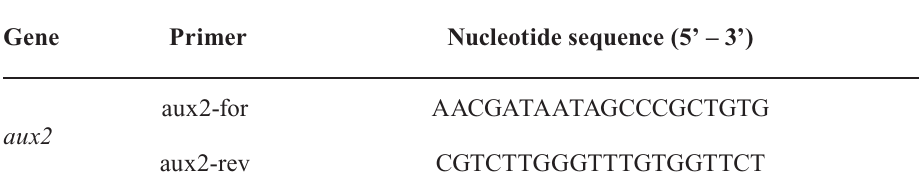
TABLE I - N ucleotide sequences of PCR primers